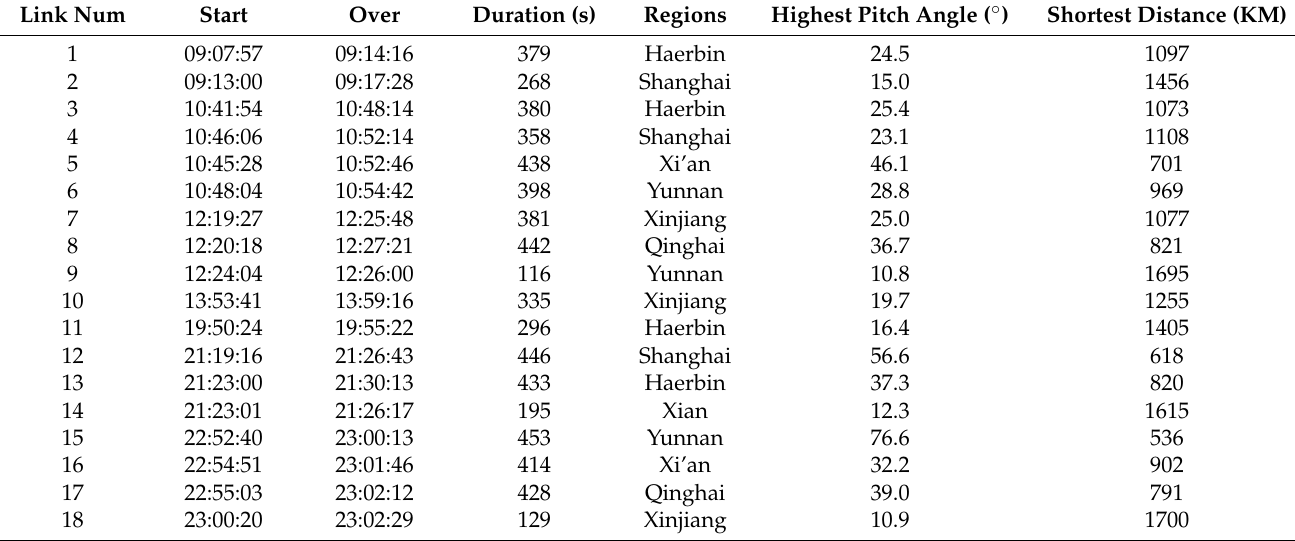
Table 2. Link status in 24 h.